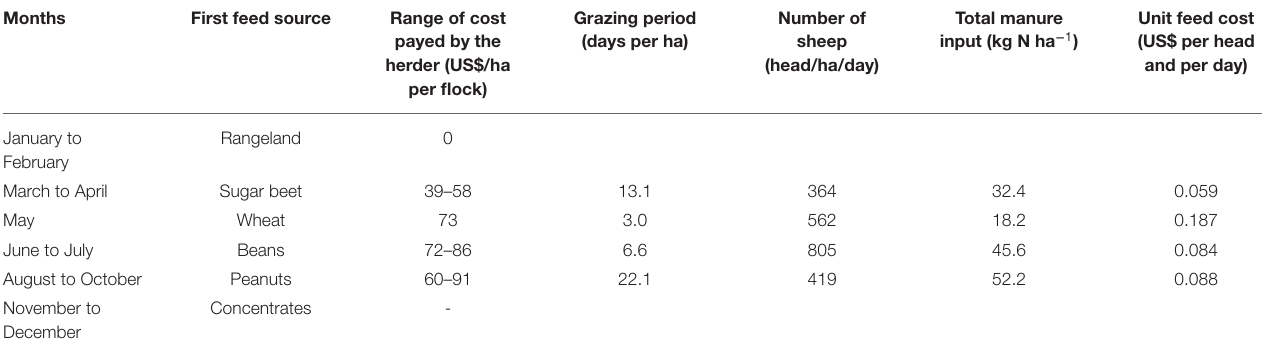
TABLE 5 | Calendar of grazing period and total head manuring per